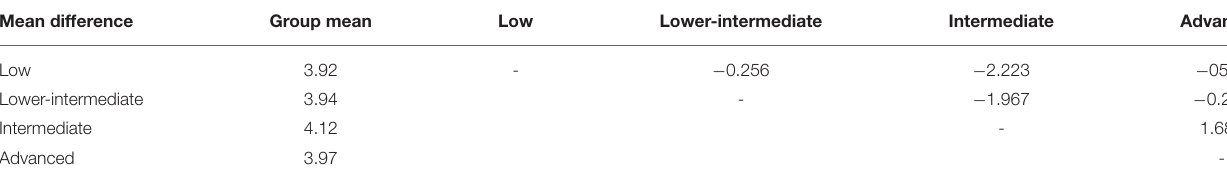
TABLE 6 | Multiple comparisons of self-perceived achievement and FLE ( N = 90).